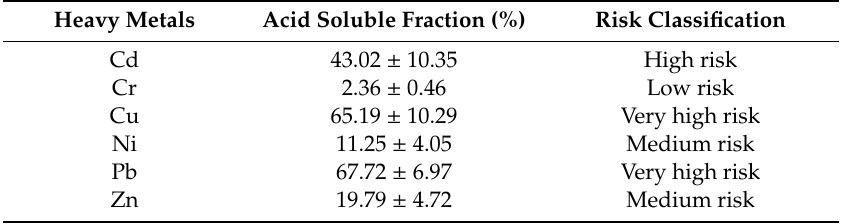
Table 8. Acid-soluble fraction of heavy metals in soil and their risk classifications.